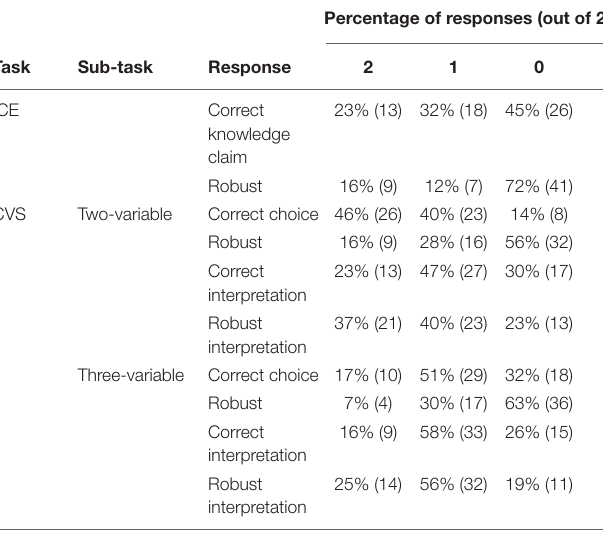
TABLE 3 | Performance across two trials of the ICE and CVS tasks.